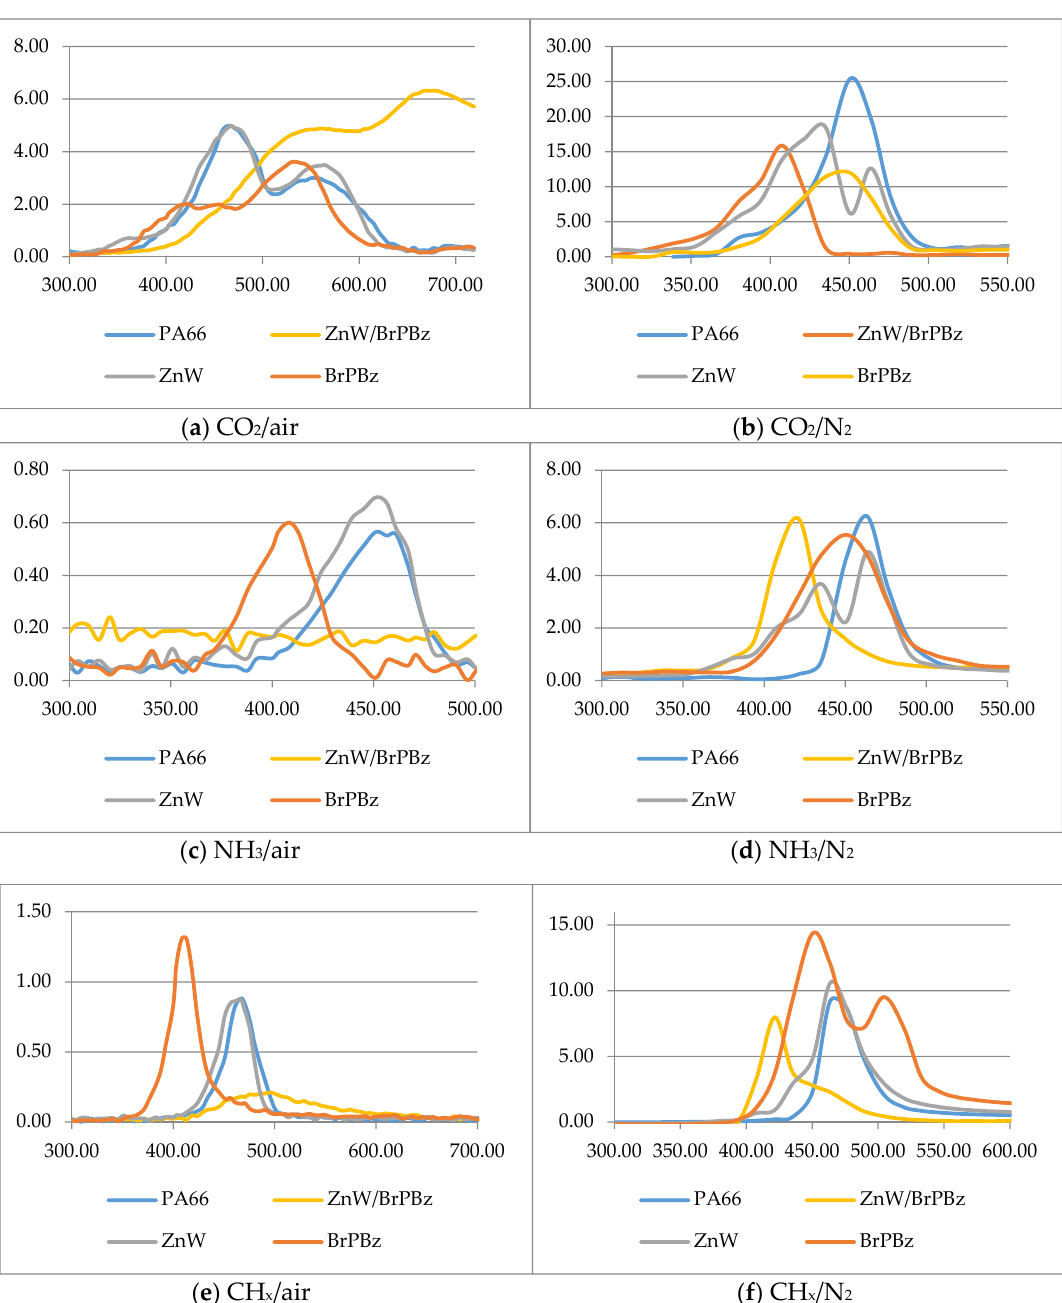
Figure 6. Plots of the intensity of CO 2 , NH 3 and CH x evolution for ZnW formulations with/without brominated polystyrene, BrPS, and poly(pentabromobenzyl acrylate), BrPBz, as measured by FTIR versus TGA temperature under air and nitrogen, respectively; CO 2 ( a , b ), NH 3 ( c , d ), CHx ( e , f ). Note that the temperatures here do not account for the approximate 45 s delay in recording the FTIR signal. SnW and ZnW = tin (II) and zinc tungstates respectively.